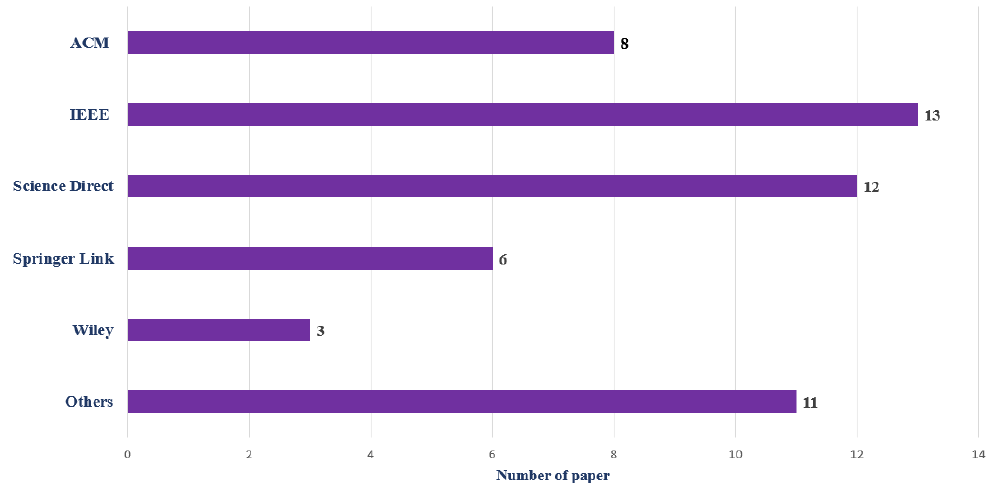
Figure 1. Distributions of the publications according to data